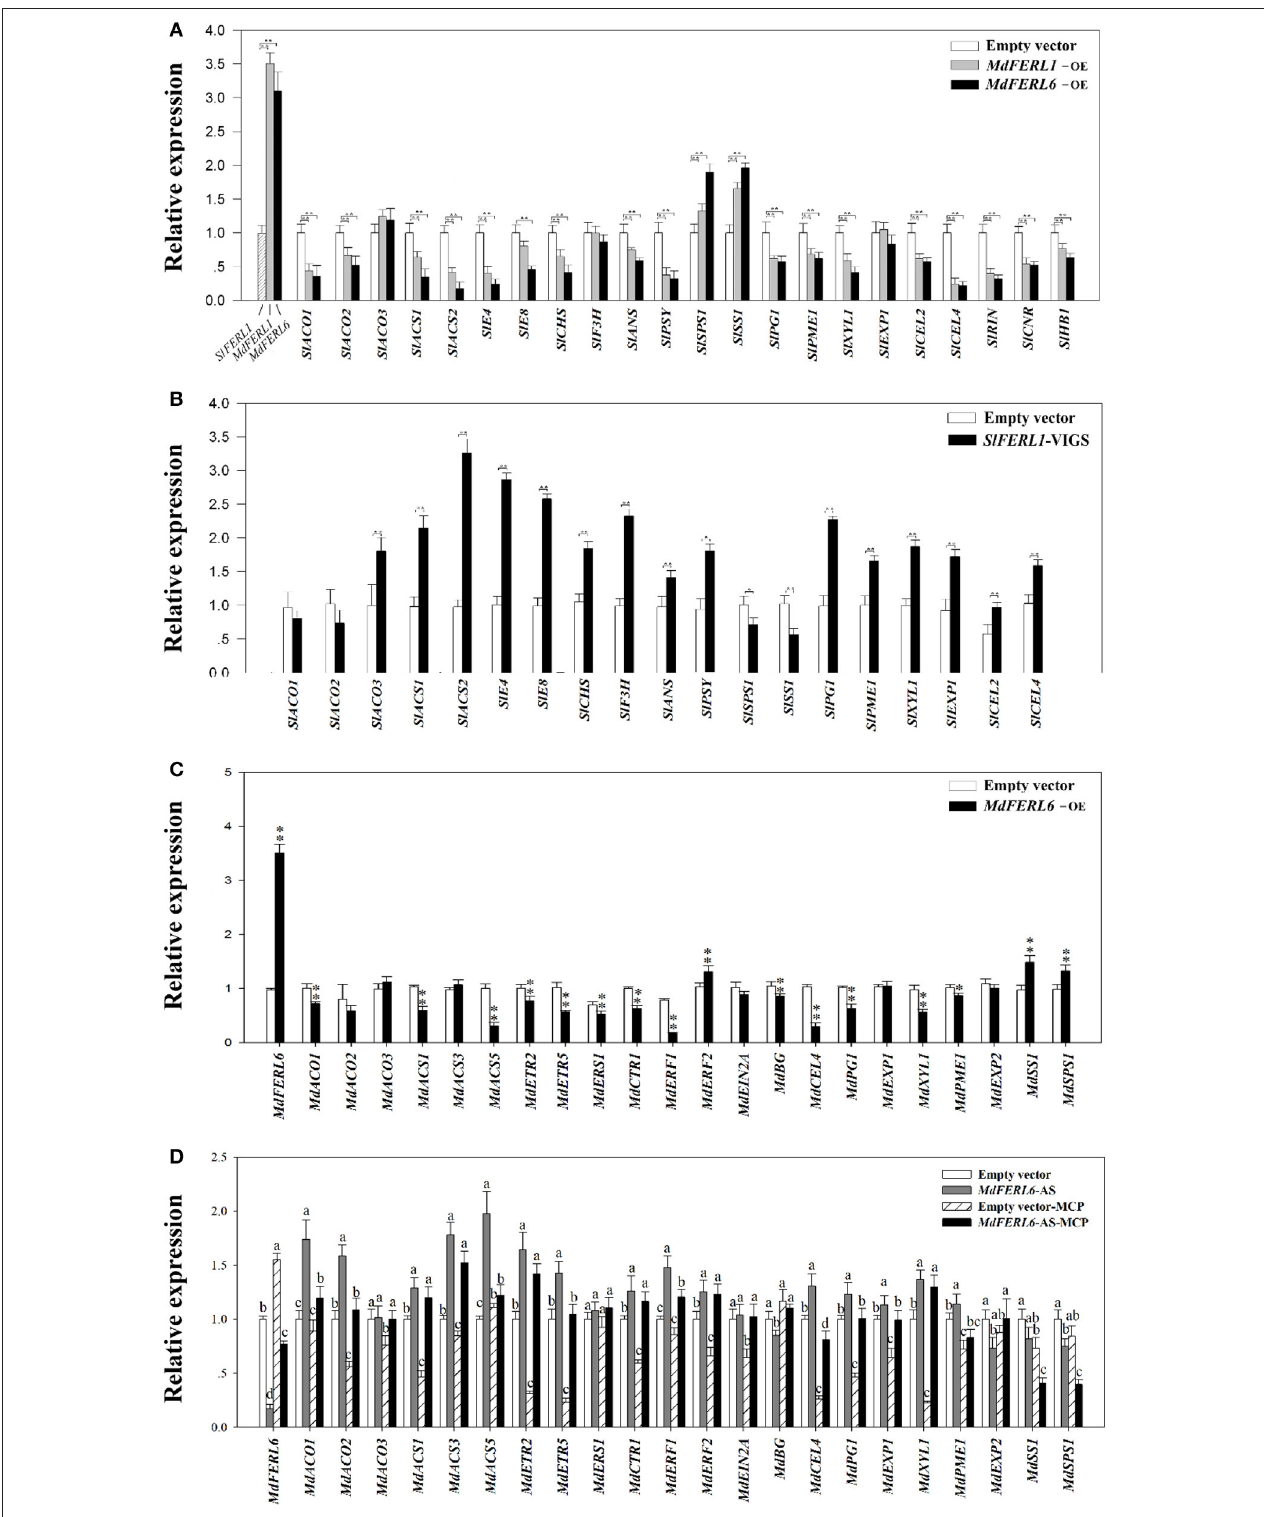
FIGURE 6 | Effect of MdFERL1, SlFERL1, and MdFERL6 on the expression of ripening-related genes. (A) Effect of MdFERL1 and MdFERL6 on the expression of tomato ripening-related genes. The MdFERL1 -OE (overexpression) and MdFERL6 -OE constructs were injected into tomato fruits at 18 DPA and gene expression